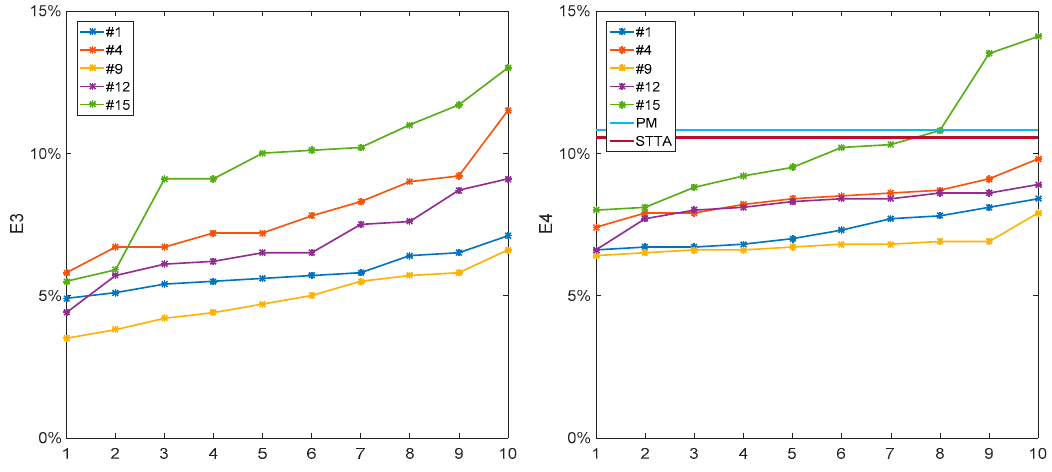
Figure 11. The average error rate of 10 times is counted, and the results are as follows. STTTA, self-tuning triple-threshold algorithm; PM, proportional method.